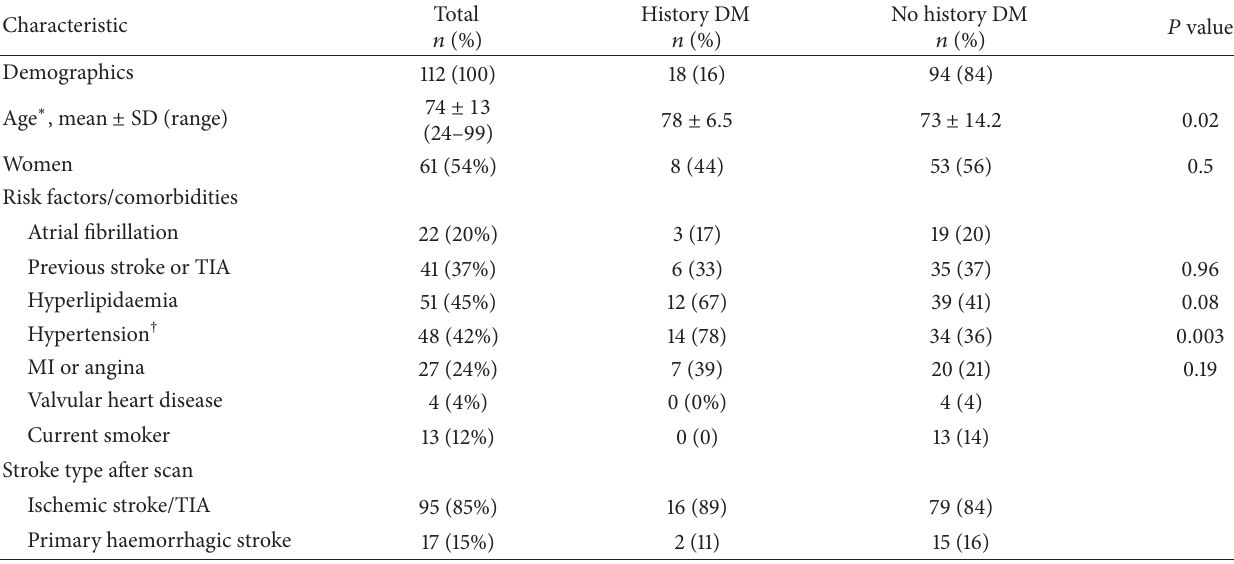
Table 1: Characteristics of the cohort and comparison between adults grouped by history of diabetes mellitus and no history of diabetes